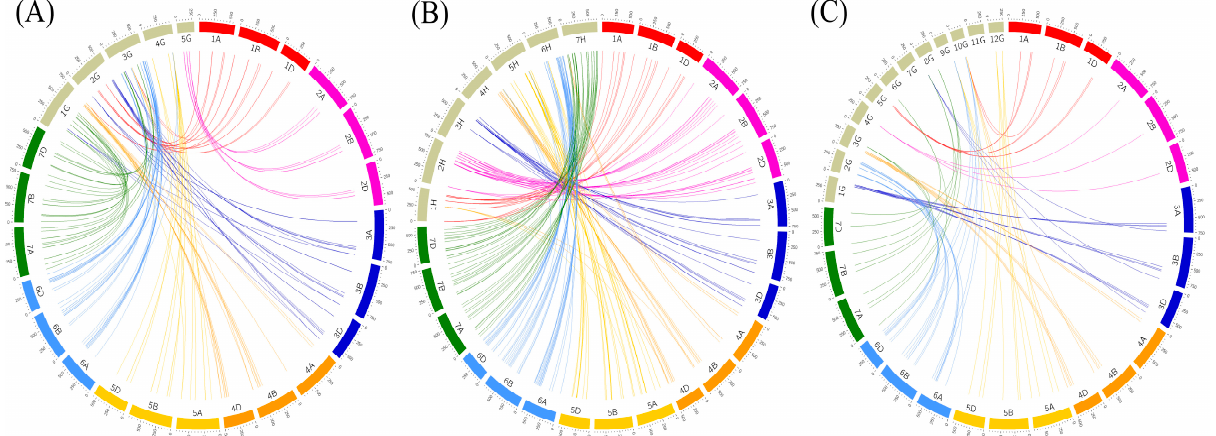
Figure 6. Synteny analysis of wheat U-box E3 genes with ( A ) Brachypodium , ( B ) barley, and ( C ) rice. For synteny analysis of wheat against Brachypodium and rice, BLASTP was conducted with an E-value threshold of 1 × 10 − 10 and sequence identity > 80%. Colored lines denote syntenic regions between wheat chromosomes and other plants. The genome size of Brachypodium and rice was enlarged by a factor of 10.